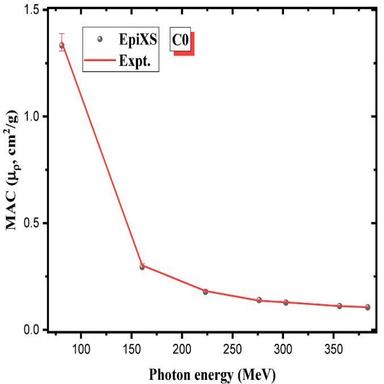
Comparison of experimental and theoretically calculated MAC values with error bars.